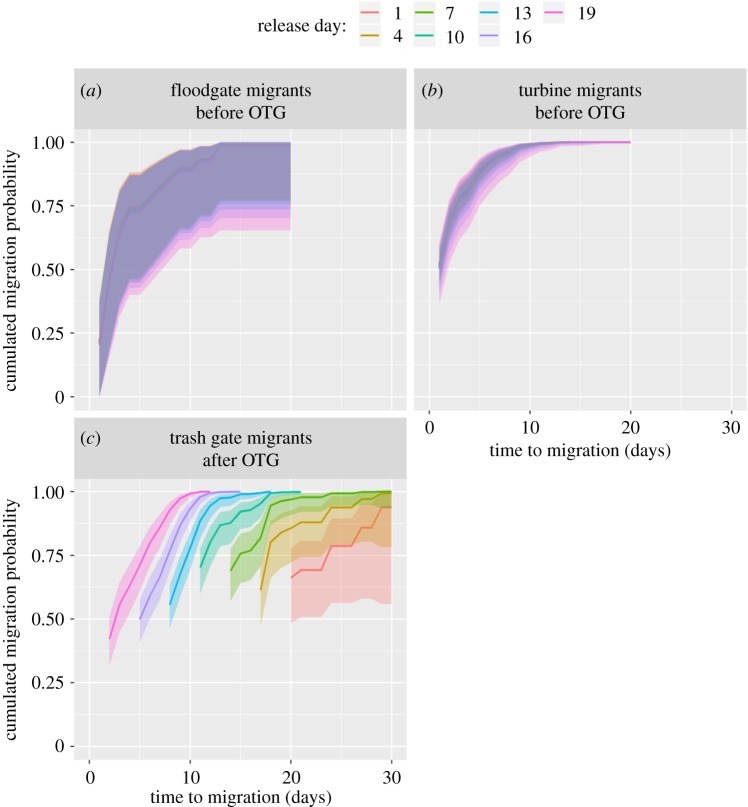
Prediction plot for the cumulated migration probabilities for the selected Cox proportional hazards model. For the floodgate (a) and turbine migrants (b), the before open trash gate (OTG) period is plotted only, as trash gate migrants do not have migration opportunities during this period. The different colours reflect different release cohorts, but they are hard to separate as the confidence bounds are largely overlapping. (c) The predicted trash gate migrants' cumulated migration trajectories for seven release cohorts (different colours) for the OTG period. The most recent cohorts appear from the left in the figure. Shaded areas correspond to 95% confidence bounds.